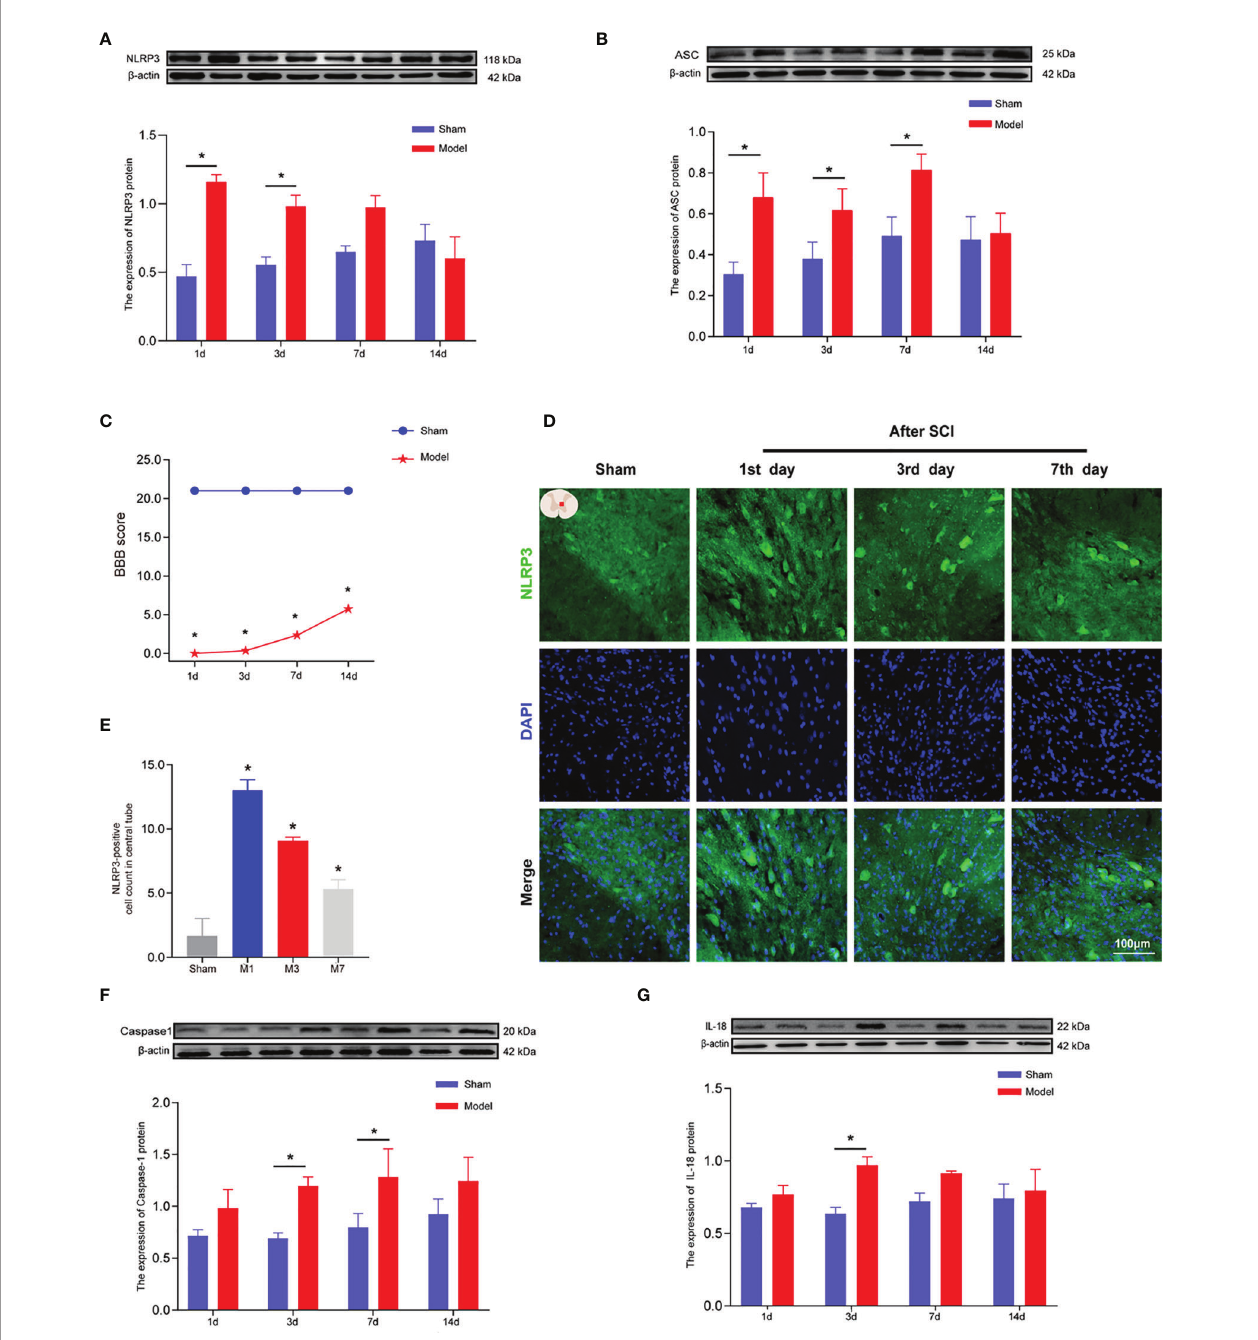
FIGURE 3 | The expression levels of NLRP3, ASC, caspase-1, and IL-18 in rat spinal cords 1, 3, 7, and 14 days after SCI. (A) Representative Western blotting and semiquantitative analysis of NLRP3 protein in the spinal cords of rats in the sham and model groups at days 1, 3, 7, and 14 post-SCI. The image shows representative Western blotting for NLRP3 and b -actin. (B) Western blotting was used to analyze the protein expression of ASC in the sham and model groups after SCI. Representative protein bands are shown for ASC at 1, 3, 7, and 14 days after SCI (N = 5 rats/group). The expression of ASC is shown for the model and sham groups. *p < 0.05; two-way ANOVA. (C) The BBB function scores in the sham and model groups. N = 8 rats/group. *p < 0.05. (D) The expression of NLRP3 in the spinal cords of rats was detected using IF. The expression of NLRP3 in the spinal cord was detected in the sham group and 1, 3, and 7 days after SCI. Cells positive for NLRP3 protein are shown in green. (E) Quantitative analysis of NLRP3-positive cells in the model group compared with the sham group. *p < 0.05; one- way ANOVA was used for comparison. N = 5 rats/group. (F, G) Protein expression and representative protein bands for caspase-1 and IL-18 at each time point after SCI as determined using Western blotting. N = 5 rats/group. *p < 0.05; two-way ANOVA was used for comparison. Data are presented as the mean ± SEM. SCI, spinal cord injury; BBB, Basso – Beattie – Bresnahan; IF, immuno fl